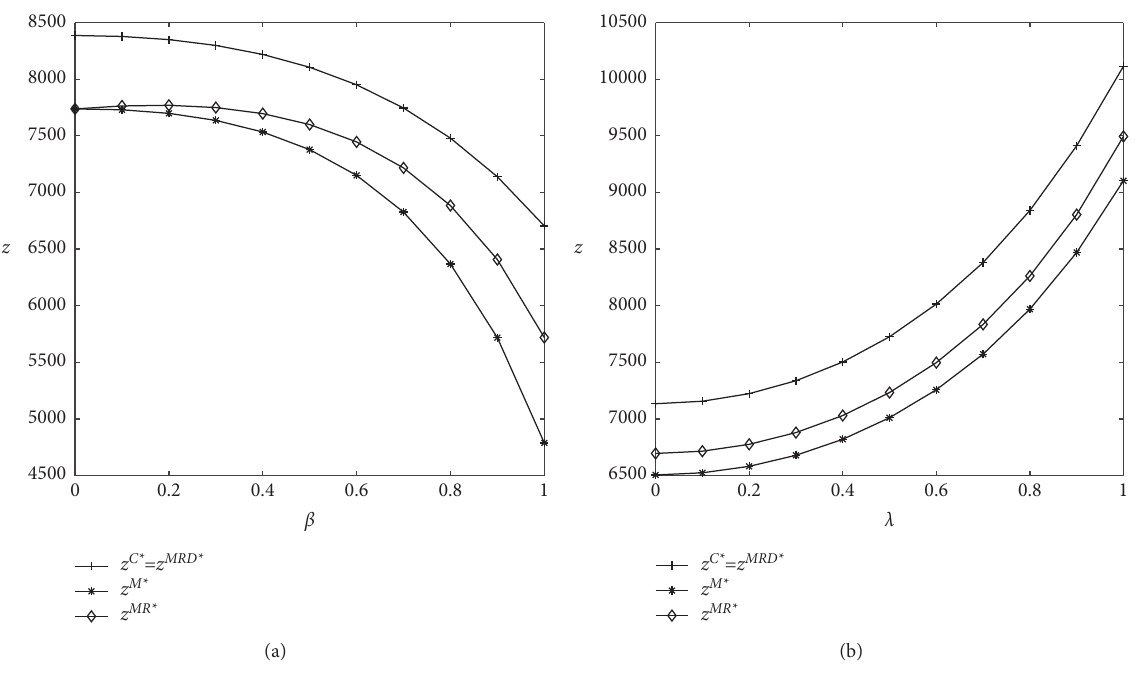
Figure 6: The effect of β and λ on the DCGSC